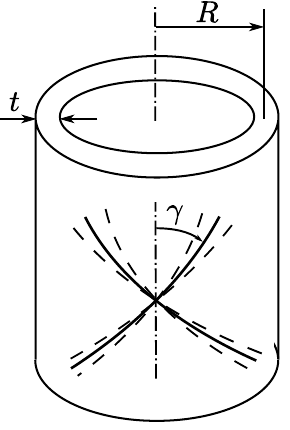
Figure 2. Representation of arterial wall with two embedded families of fibres. The mean orientations of the collagen fibres are characterized by the angle γ